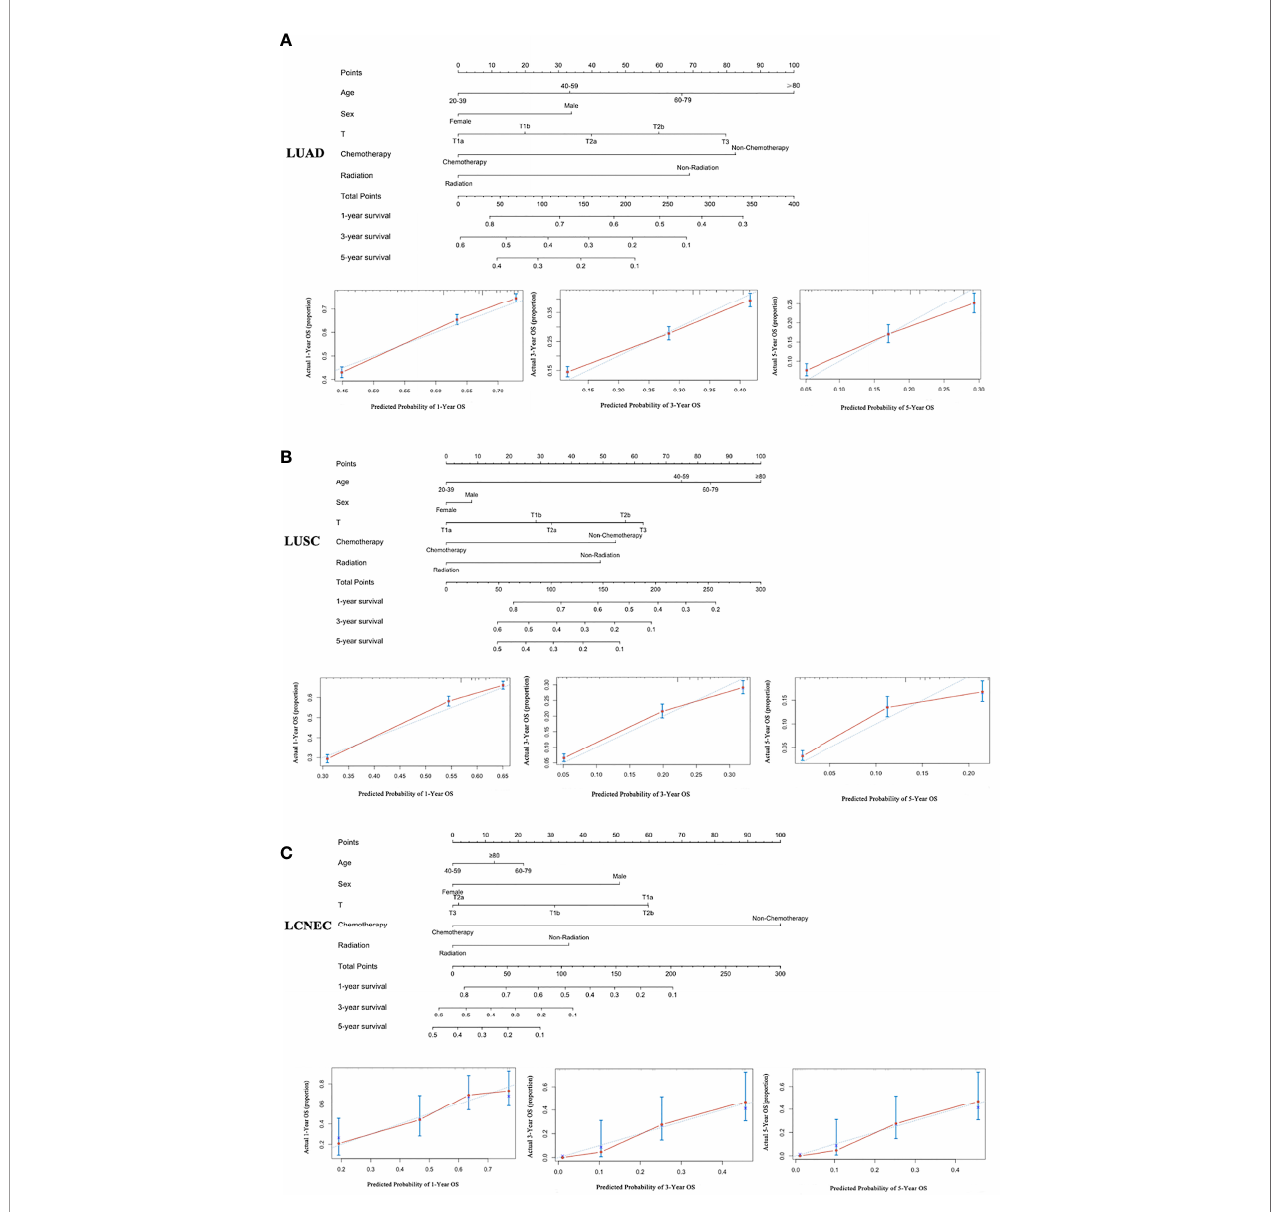
FIGURE 2 | A nomogram for the prediction of 1-, 3-, and 5-year OS rates and the corresponding calibration curve: (A) LUAD, (B) LUSC, and (C)